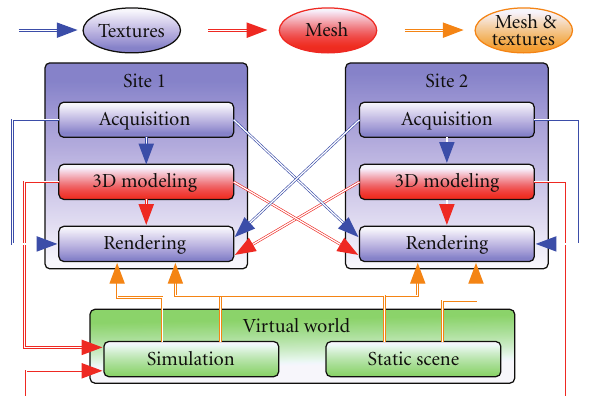
Figure 9: Application architecture for two multicamera acquisition spaces and a virtual physical